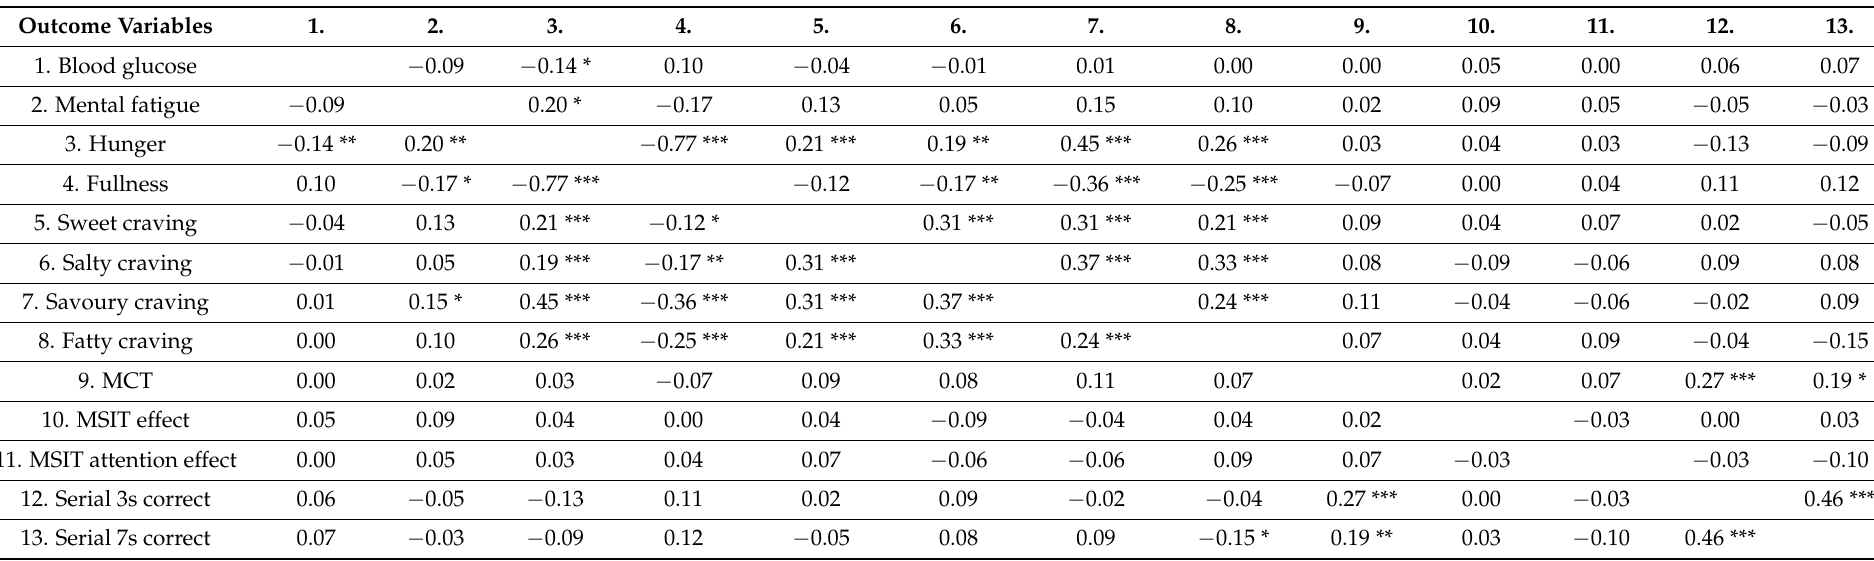
Table 3. Within-participant correlations between change scores for all study